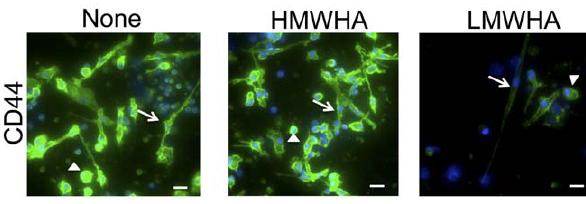
Figure 7. HMWHA and LMWHA have different effects on the expression of CD44. PBMC were incubated in SFM, SFM with 300 m g/ ml HMWHA, or SFM with 300 m g/ml LMWHA for 5 days. The PBMC were then fixed and stained for CD44. In all panels, nuclei are stained blue with DAPI and bars are 20 m m. Arrows indicate fibrocytes and arrowheads indicate non-fibrocyte cells. The figures represent one of 3 independent experiments.